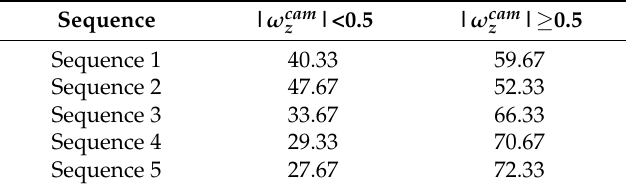
Table 2. Percentage of the motion estimation cases.